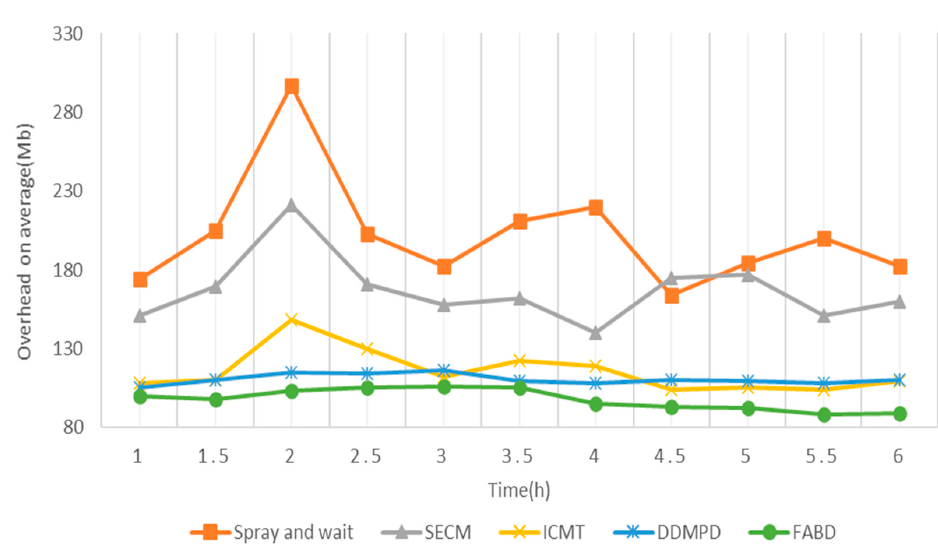
Figure 5. The relationship between average cost and time.